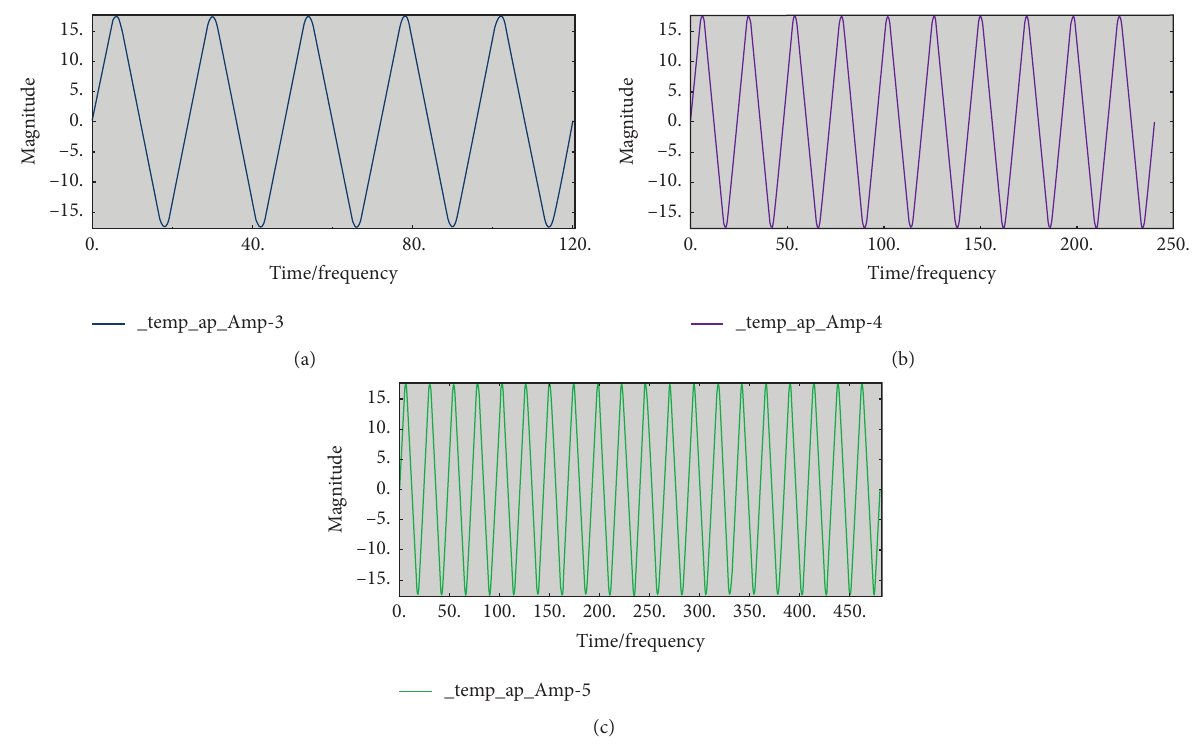
Figure 3: Freeze-thaw